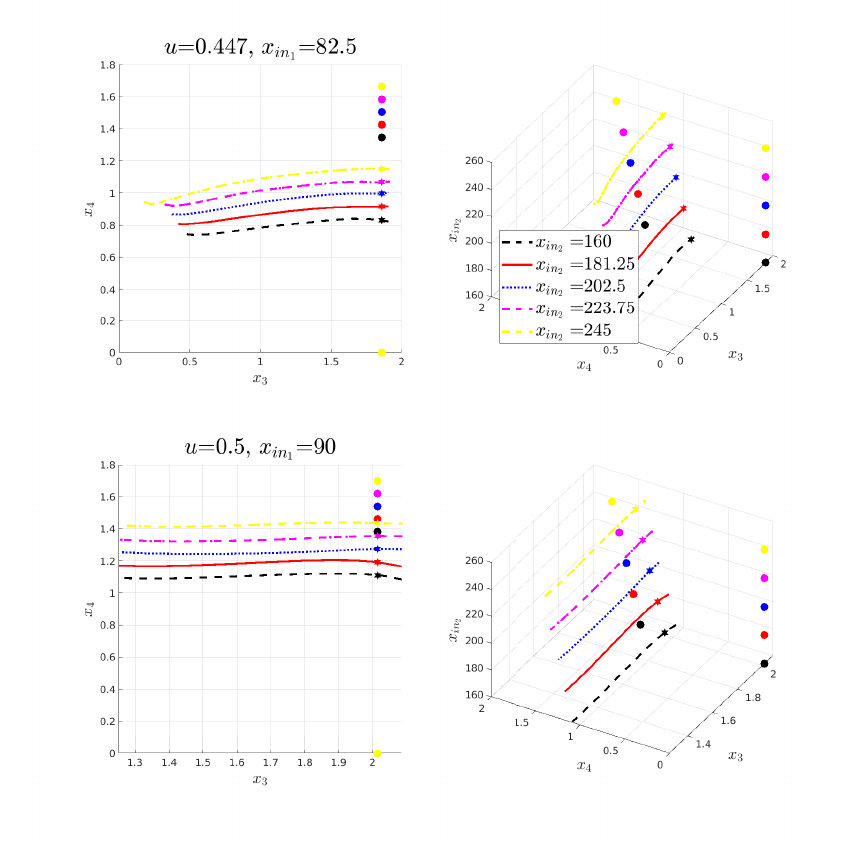
, and constant dilution rate, and x in 2